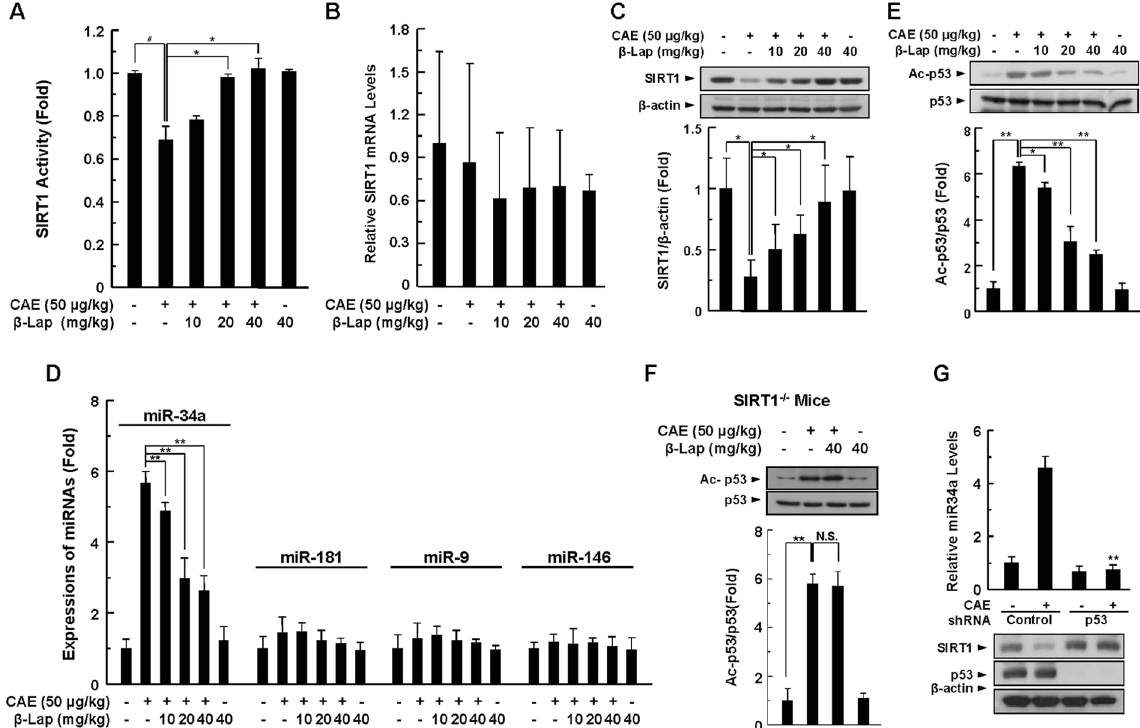
Figure 4. Effect of β -Lap on pancreatic SIRT1 activity in WT mice during caerulein-induced AP. ( A ) Pancreatic tissue was isolated 11 h after the final injection of caerulein, and then SIRT1 activity was measured using a SIRT1 assay kit. ( B , C ) SIRT1 mRNA and protein levels in pancreatic tissue were measured by qRT-PCR ( B ) and western blotting ( C ). ( D ) miR-34a, miR-181, miR-9, and miR-146 were analysed by qRT-PCR. ( E , F ) Acetylated p53 and total p53 were detected by western blotting using anti-acetylated p53 and anti-p53 in WT ( E ) and SIRT1 − / − mice ( F ). ( G ) Isolated acinar cells were treated with lentiviral particles containing control or p53 specific shRNA for 12 h. Cells were further treated with caerulein (1 μ M) for 24 h, then the miR-34a level was measured by qRT-PCR. SIRT1 and p53 levels were determined by western blotting. Each value represents the mean ± SD ( n ≥ 3). * P < 0.05, ** P <